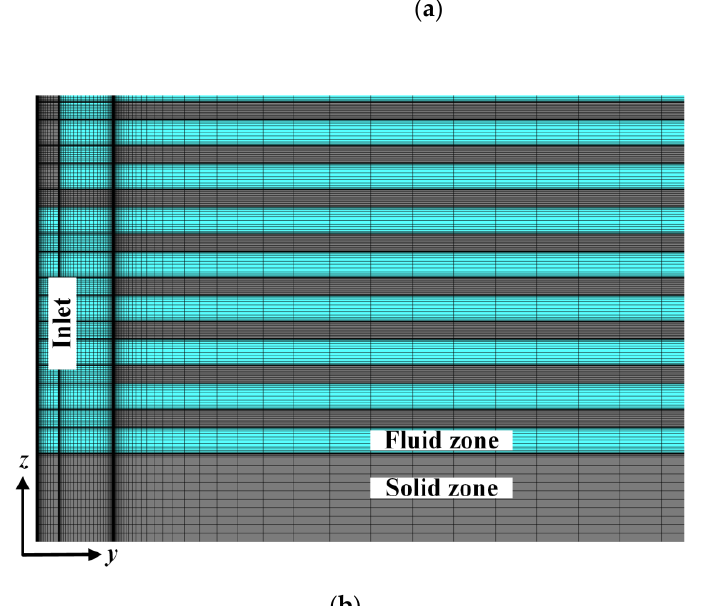
Figure 4. Schematic of grids for the computational domain: ( a ) 3D structure; ( b ) sectional grids at½ height plane.